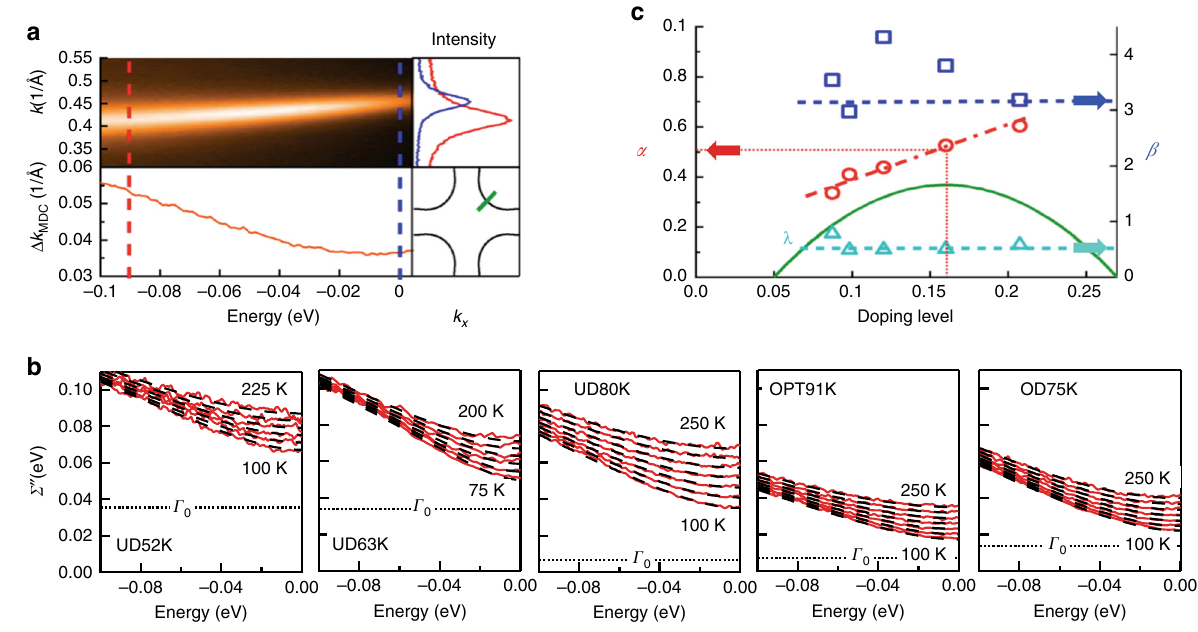
Fig. 1 Experimental electronic self energy Σ ” as a function of energy, temperature, and doping. a The self energy is extracted from an ARPES spectrum (top left) located at the node (green cut, bottom right) by taking momentum cuts at constant energy (top right) to extract momentum widths Δ k MDC ( ω ) (bottom left) which are directly proportional to Σ ” ( ω ). b Measured temperature and energy dependence of Σ ” for fi ve different samples from underdoped T = 52K (UD52K) through optimal doped T = 91K (OPT91K) to overdoped T = 75K (OD75K). c Fit results for the three main parameters in the model as c c c a function of doping. The superconducting dome is schematically illustrated by the inverted parabola. The most relevant parameter is the power α which is seen to have a simple linear dependence on doping with value 0.5 very near optimal